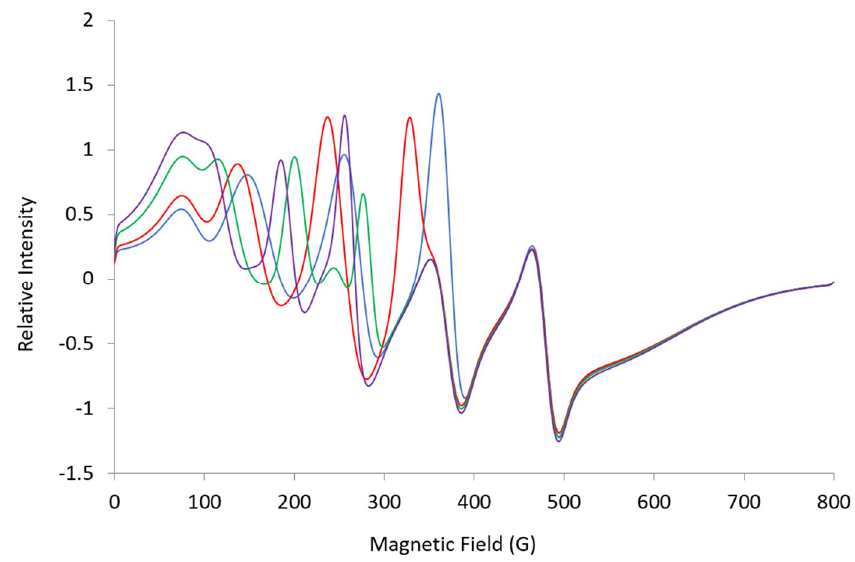
Figure 6. Simulated L-band (1.37 GHz) spectra: A = [369, 508, 100], g eff = [4.96, 4.55, 1.94], HStrain = [150, 150, 600] (blue); g -max = 5.5 (red), 6.5 (green), 7.0 (purple). Changes show lines sensitive to g -max.